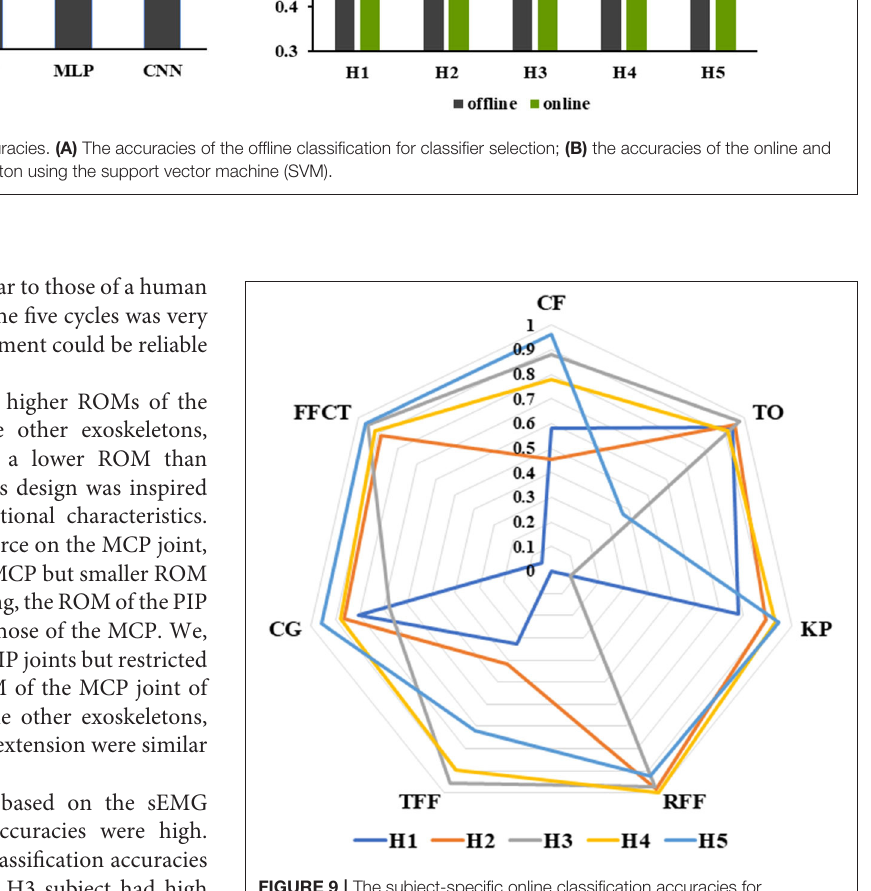
FIGURE 9 | The subject-specific online classification accuracies for recognizing the hand